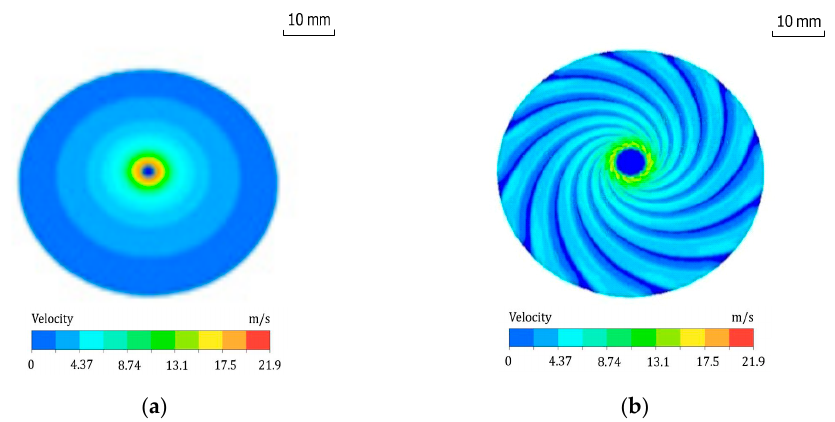
Figure 4. Velocity field of slurry film in the horizontal section. The fluid film thickness of the CFD model is 100 μ m, the pressure of the slurry inlet is 0.3 MPa and the rotational speed of disc polishing is 3000 rpm. ( a ) Without groove, ( b ) with grooves.